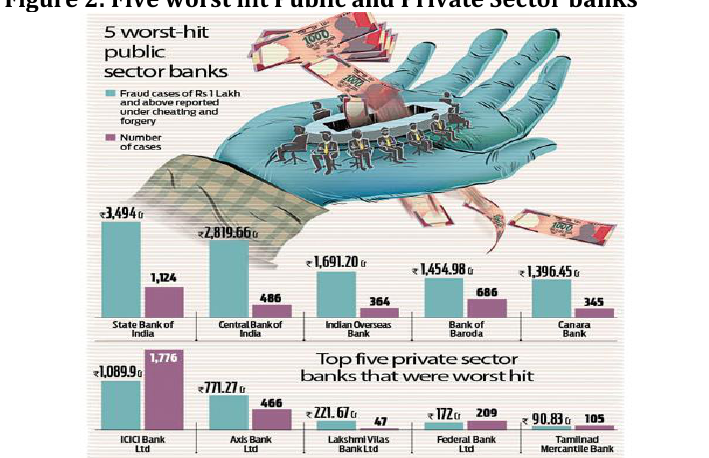
Figure 2: Five worst hit Public and Private Sector